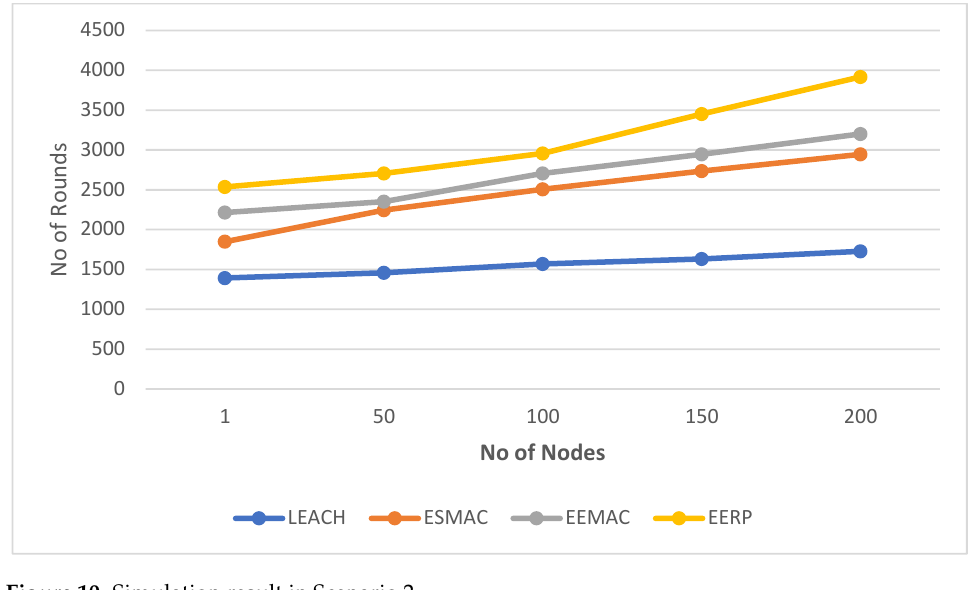
Figure 10. Simulation result in Scenario 2.